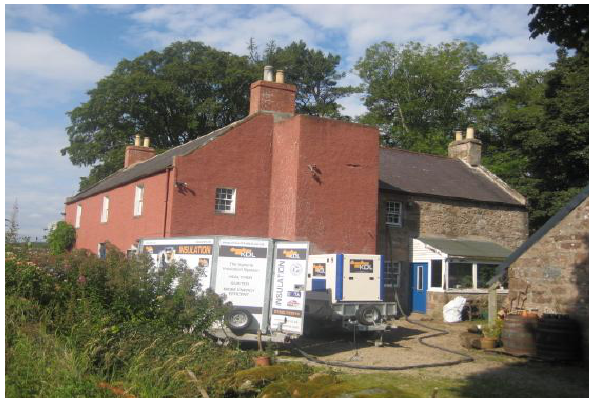
Figure 1. View of the house during the insulation process For the Scottish context this research/experiment will concentrate on existing load-bearing masonry construction with internal plastered lath lining.